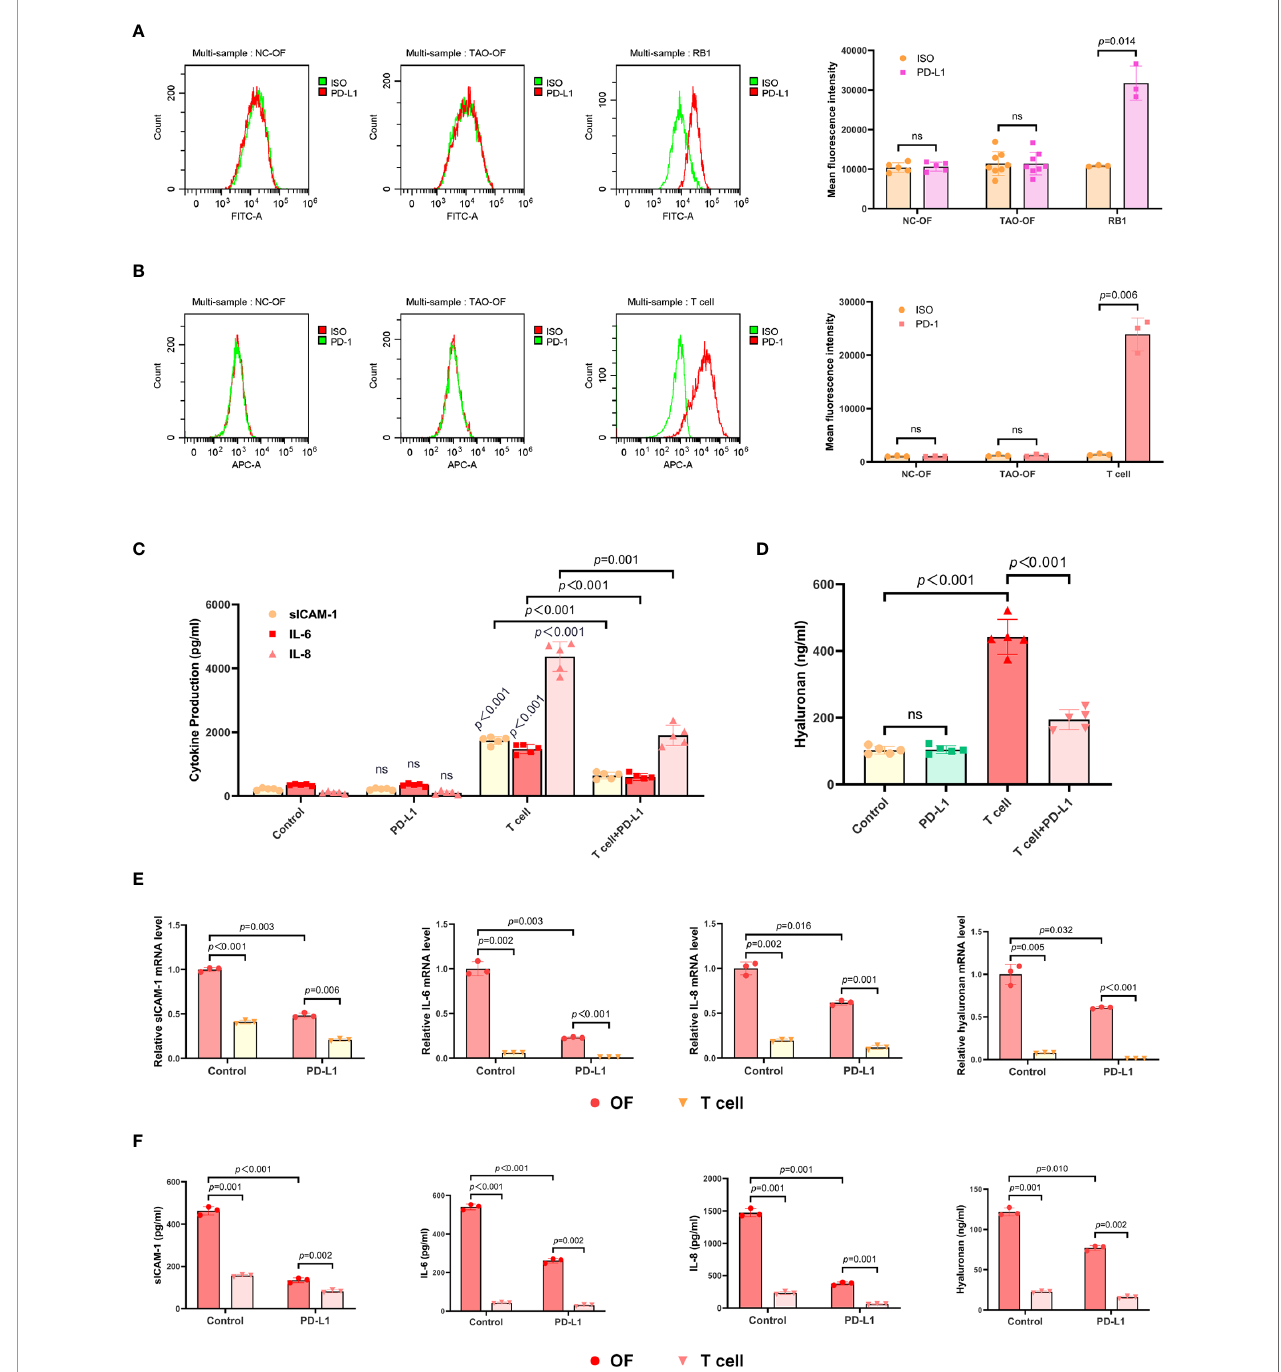
FIGURE 2 | The expression of PD-L1 in OFs and the effect exogenous PD-L1 exerted on the OF-T cell co-culture system. (A) OFs from TAO patients and negative controls were subjected to FCM to detect the expression of PD-L1. (B) OFs from TAO patients and negative controls were subjected to FCM to detect the expression of PD-1. (C, D) TAO-OFs were stimulated with PBS, PD-L1 (10 ug/mL), autologous T cells (OFs: T cells = 1: 10), and PD-L1 combined with T cells for 48 hours, respectively. And the supernatants were subjected to analysis of sICAM-1, IL-6, IL-8, (C) and HA (D) production by ELISA. (E, F) TAO-OFs were co-cultured with autologous T cells (OFs: T cells = 1: 10) for 48 hours, and the two cells were subjected to qPCR to assay mRNA expressions of sICAM-1, IL-6, IL-8, and HA (E) , or to ELISA to detect the production of sICAM-1, IL-6, IL-8, and HA in cytoplasm (F) . Data are expressed as mean ± SD of three or more repetitions. ns, no signi fi cance. Representative of three or more independent experiments using cells from a different